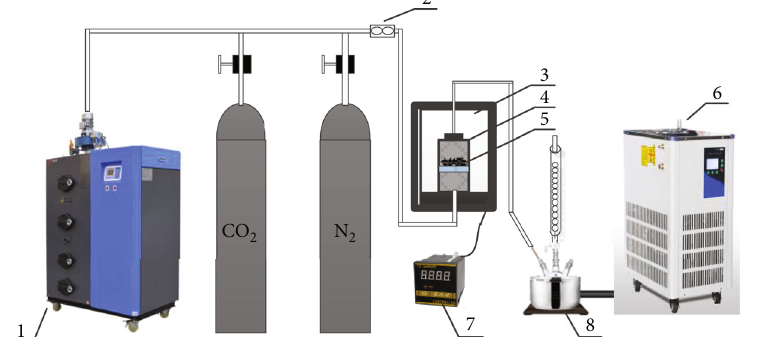
Figure 1: Pyrolysis experiment system of JM oil shale; 1: water vapor generator; 2: gas fl ow meter; 3: pyrolysis furnace; 4: pyrolysis reactor; 5: oil shale sample; 6: cooling water circulation device; 7: temperature controller; 8: condensing